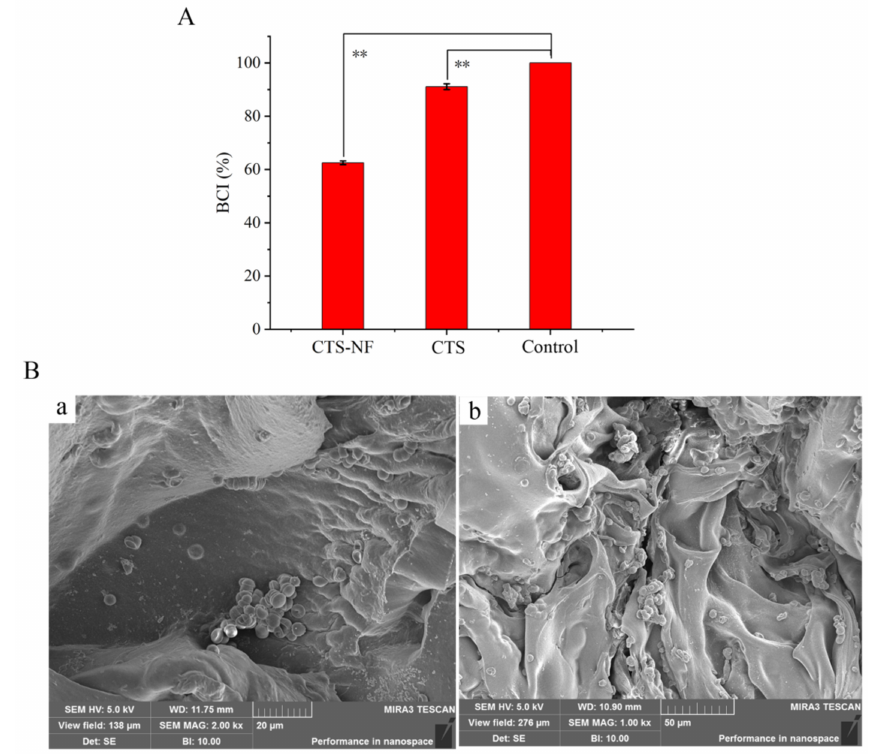
Figure 9. BCI of the samples ( A ); the SEM micrographs of the adsorption of red blood cells on the CTS-NF sponge surfaces ( B ), ( a ) the electron microscope of 2.00 kx; ( b ) the electron microscope of 1.00 kx). ** p < 0.01 indicates significant difference from the control